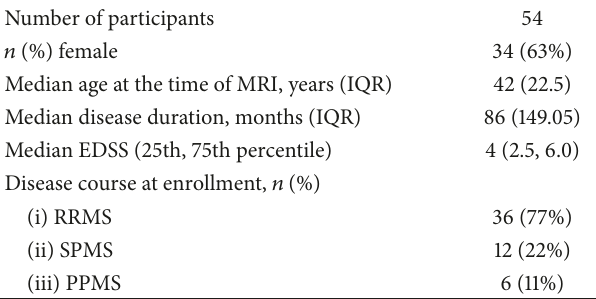
Table 1: Cohort demographic